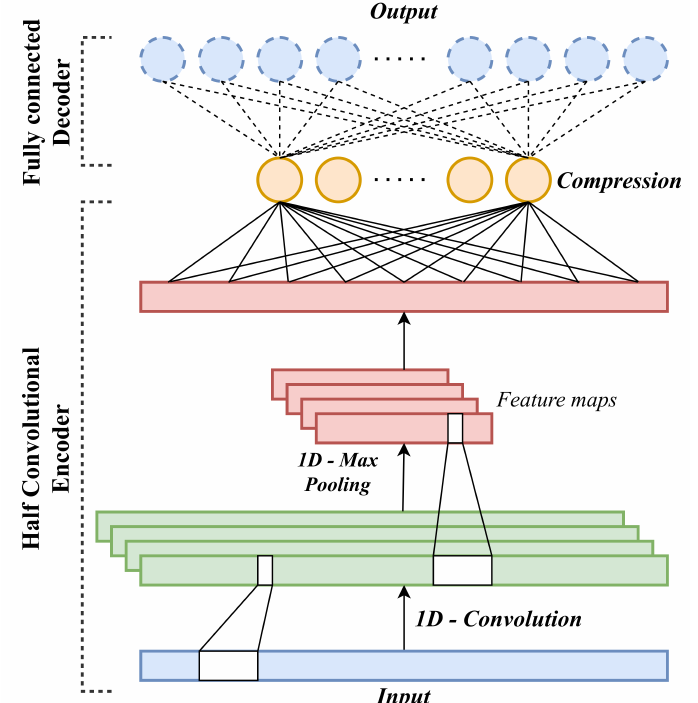
Figure 3. Architecture of the proposed HCAE: the encoder is based on a 1D-CNN whilst the decoder remains fully